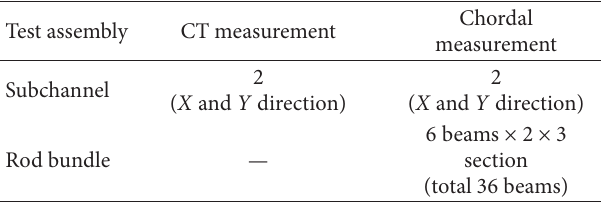
Table 13: Accuracy of process parameters in DNB